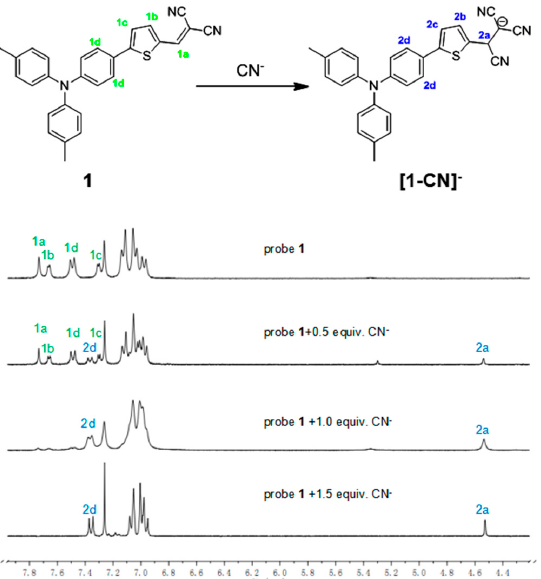
Figure 4. 1 H-NMR spectral changes of probe 1 (20 mM) upon addition of CN − (as tetrabutylammonium salts) in CDCl 3 .